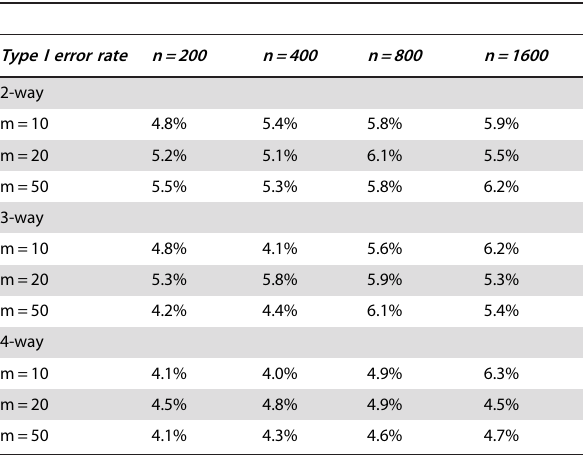
Table 2. Success rate table for MDR, GMDR and